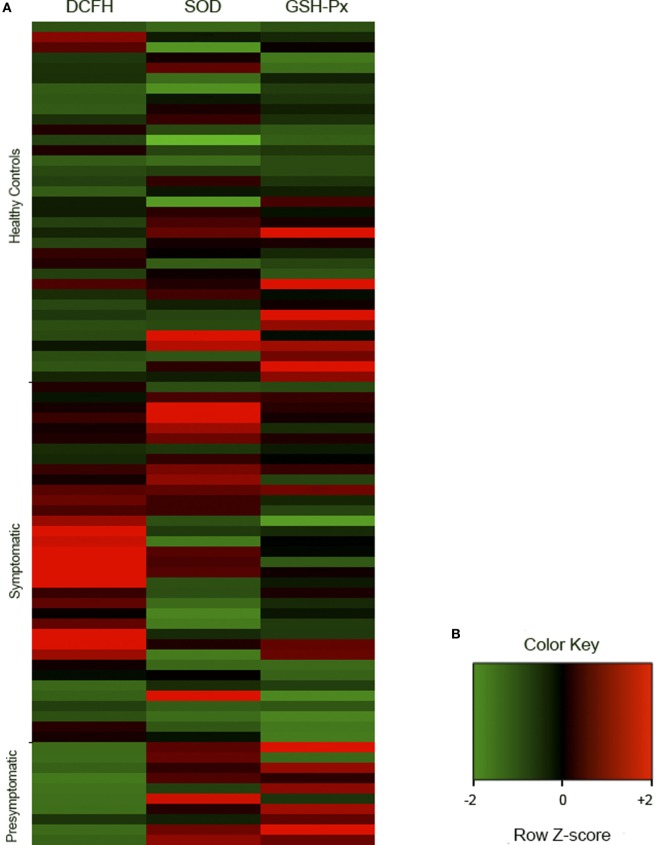
Representative cluster of the redox analyses in healthy controls (n = 35), symptomatic (n = 35), and presymptomatic (n = 10) SCA3/MJD individuals. The results were analyzed as Ζ-score values. Ζ is negative when the sample value is below the population mean and positive when it is above the mean. (A) Each square represents one individual. DCFH-DA, 2′,7′-dichlorofluorescein diacetate; GSH-Px, glutathione peroxidase; SCA3/MJD, spinocerebellar ataxia type 3/Machado–Joseph disease; SOD, superoxide dismutase. (B) Color key of row z-score.